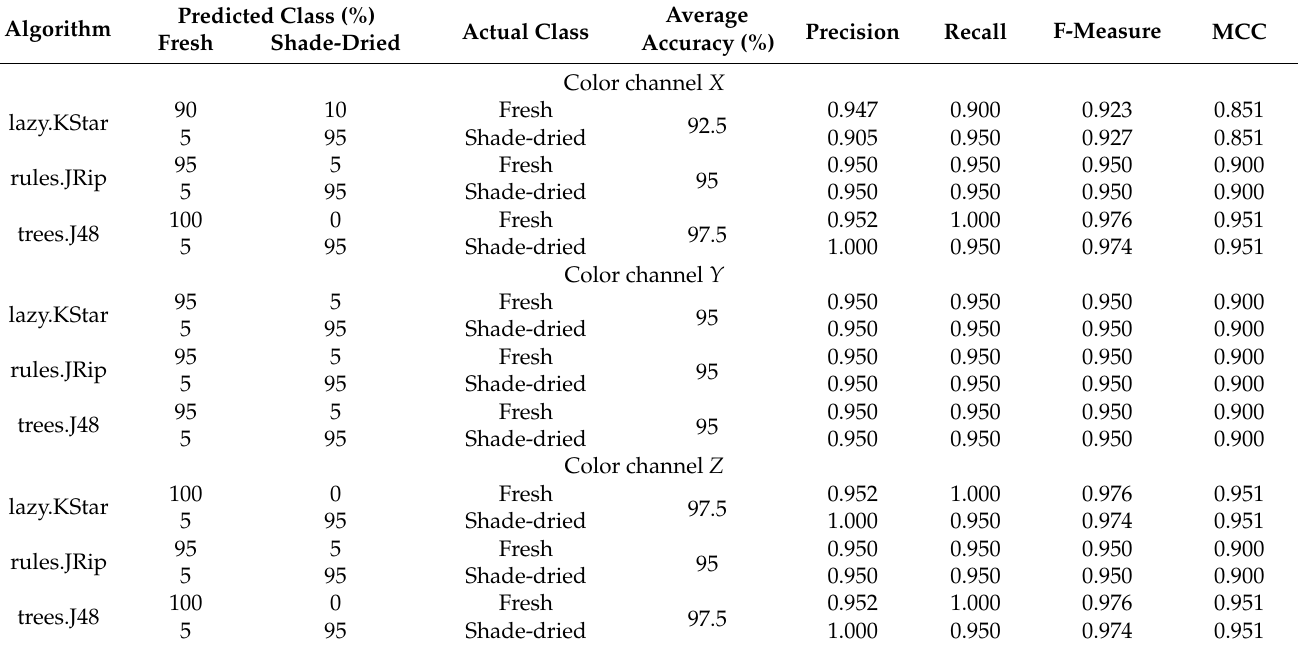
Table 9. The results of the classification of fresh and shade-dried mint leaves imaged on the dorsal side using models built based on selected texture parameters from color channels X , Y , and Z of